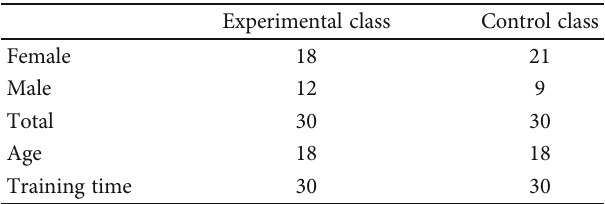
Figure 8: Schematic diagram of teaching platform. Table 3: Introduction to experimental class and control